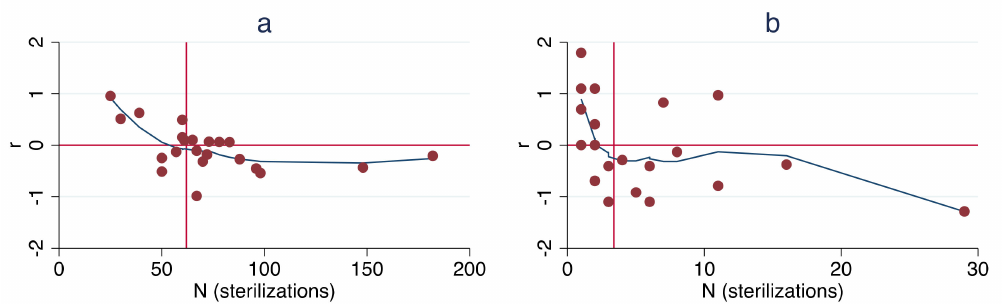
Figure 4. Calculated per capita growth rate vs. annual sterilization surgeries with LOWESS smoothing, ORCAT program 1995–2016 ( a ) and UCF program 1995–2018 ( b